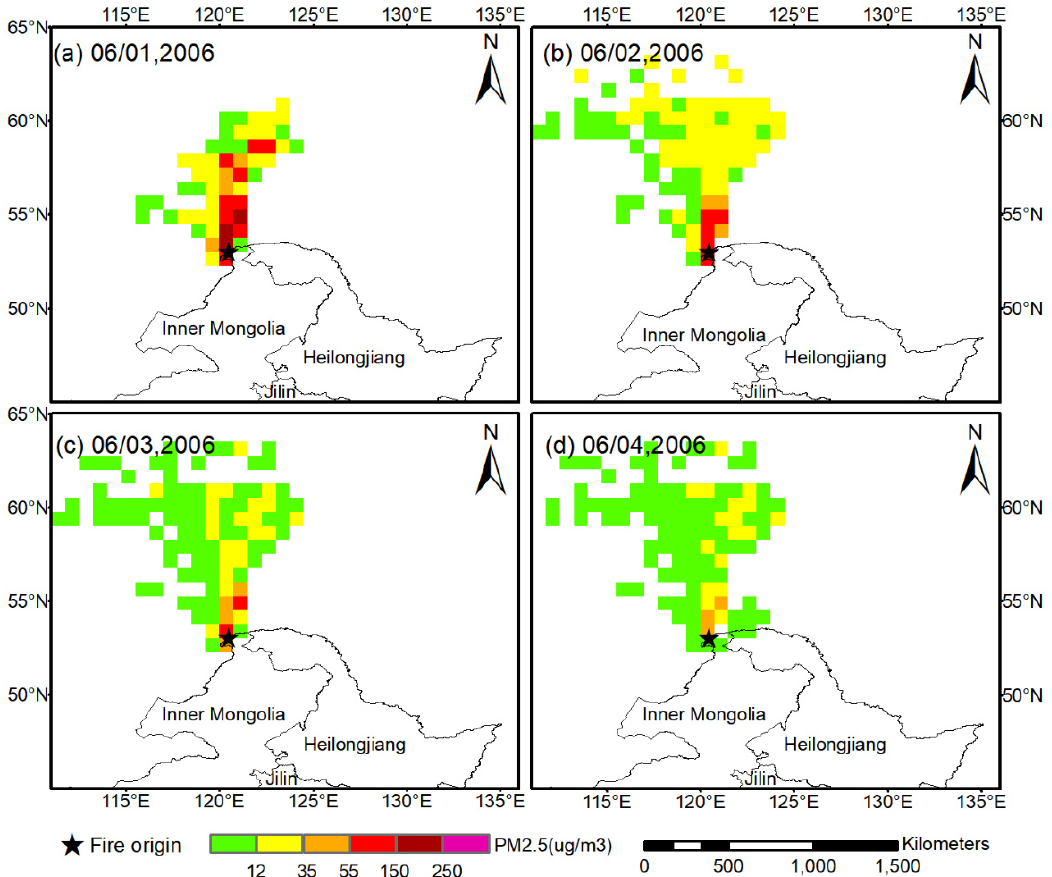
Figure A3. Same as Figure A1 except for the Yimuhe fire. Panels ( a – d ) are 1, 2, 3, and 4 June 2006, respectively.